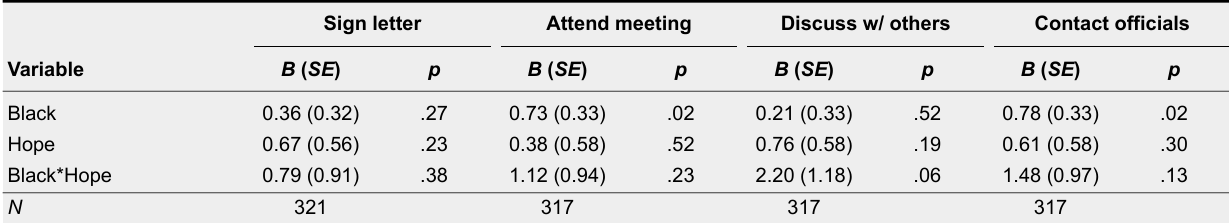
Ordered Logit Models Interacting Subject Race and Reported Hope on Participation Likelihood